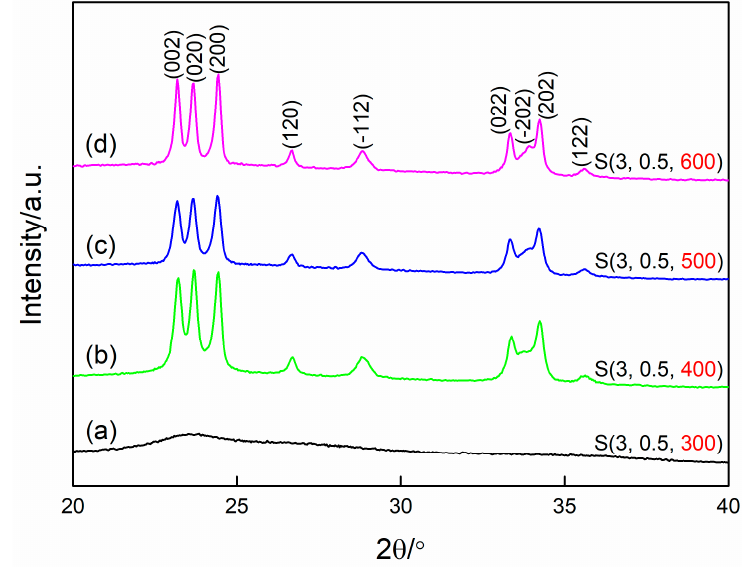
Figure 8. X-ray diffraction patterns of WO 3 films prepared at different calcination temperatures. ( a ) 300 °C, ( b ) 400 °C, ( c ) 500 °C, ( d ) 600 °C.